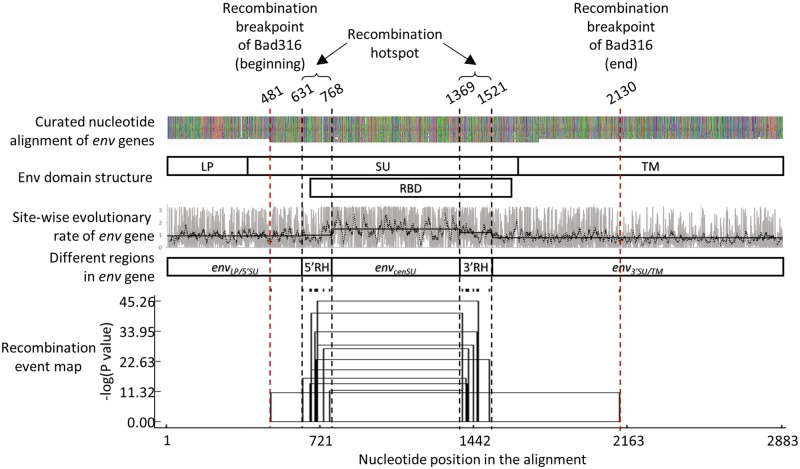
Recombination analysis.From top to bottom:
Curated env alignment. The alignment contains fifty-four sequences, forty-seven of which are full-length sequences. The total length of the alignment is 2,883 nucleotides, including gaps.Schematic outline of the Env domain structure. LP, leader peptide; SU, surface domain; TM, transmembrane domain; RBD, receptor binding domain.Site-wise evolutionary rates of env gene. The rates are scaled such that the average rate across all sites is 1 (no units). Site-wise scaled rate values are plotted in grey. Black dotted line shows moving average, computed over a window of 10 rate estimates. Black solid lines show average values of the rate estimates within various regions of the env gene. envLP/5′SU: 0.941; 5′ RH: 0.995; envcenSU: 1.491; 3′ RH: 1.209; env3′SU/TM: 0.788.Schematic outline of the envLP/5′SU, envcenSU, env3′SU/TM, and RH regions of the env gene.Recombination event map. The plot shows estimated positions of recombination breakpoints, and the P values associated with the detected recombination signals. The tick marks above the plot indicate individual recombination breakpoints inferred. Two RHs were found; the first region is between 631 and 768 nt (5′ RH), and the second one is between 1,369 and 1,521 nt (3′ RH) of the alignment. The regions are indicated by black vertical dotted lines. We noted that, while our analyses inferred the env sequence ‘Bad316’ to be a recombinant, its recombination break points lie outside the detected RHs, estimated to be at 481 nt, and 2,130 nt, indicated by vertical red dotted line.